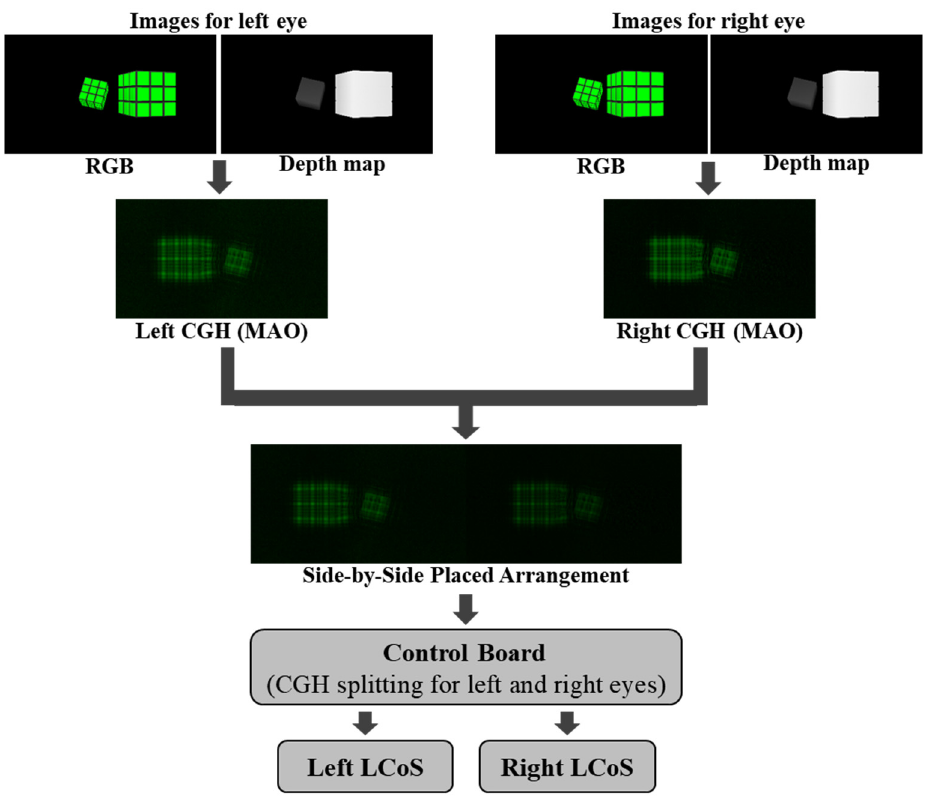
Figure 6. Process to prepare CGH content of a frame fit for the dual-view holographic display made up of two AM SLMs.